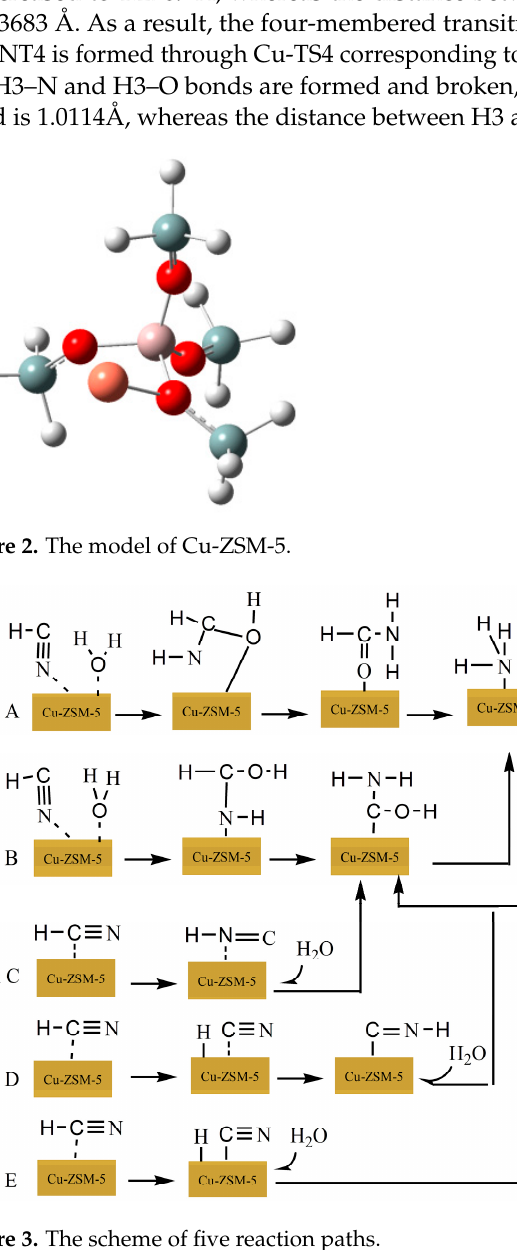
Figure 4. B3LYP/6-31++G (d,p)-optimized structures (in Å) of the stationary points of hydrolysis of HCN with Cu-ZSM5 in the gas phase of path A. The values correspond to the relative free energy ( ∆ G) in kcal/mol with respect to the separate reactants.